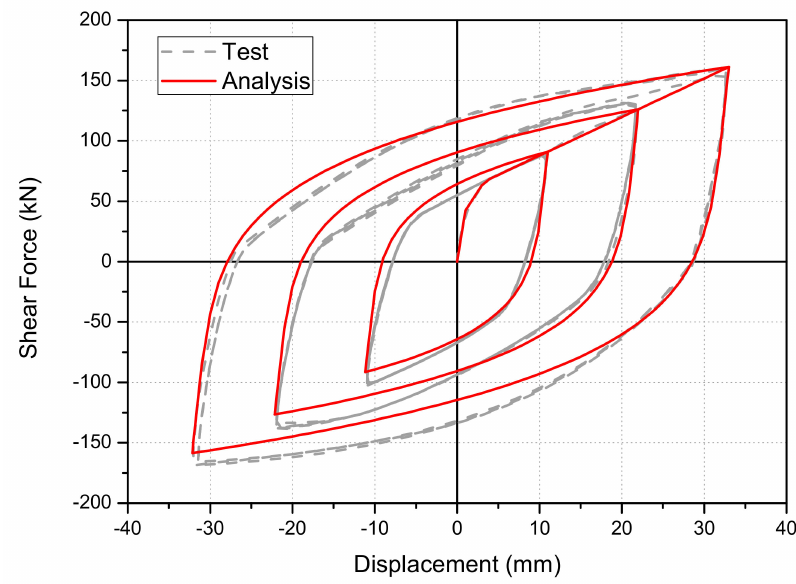
Figure 23. Comparison of the nonlinear analysis and material test results of